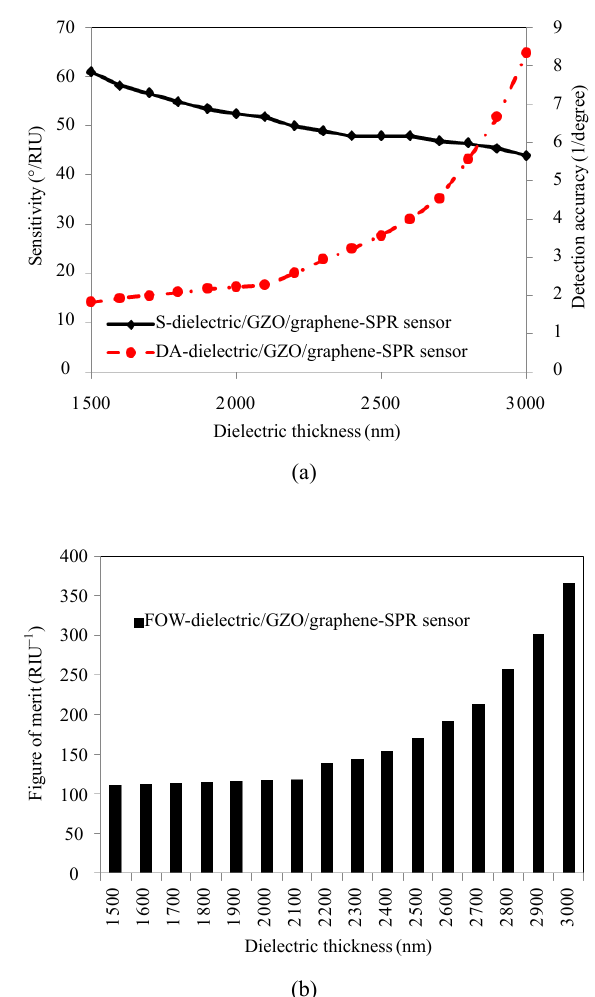
Fig. 7 Plot of (a) sensitivity and DA vs. dielectric thickness and (b) FOM vs. dielectric thickness for dielectric layer thickness variation of 1 500 nm – 3 000 nm for the proposed SPR sensor (thicknesses used for graphene and GZO are 0.34 nm and 20 nm, respectively; RIs for the sensing medium and dielectric medium are n s = 1.33 and n d = 1.34,